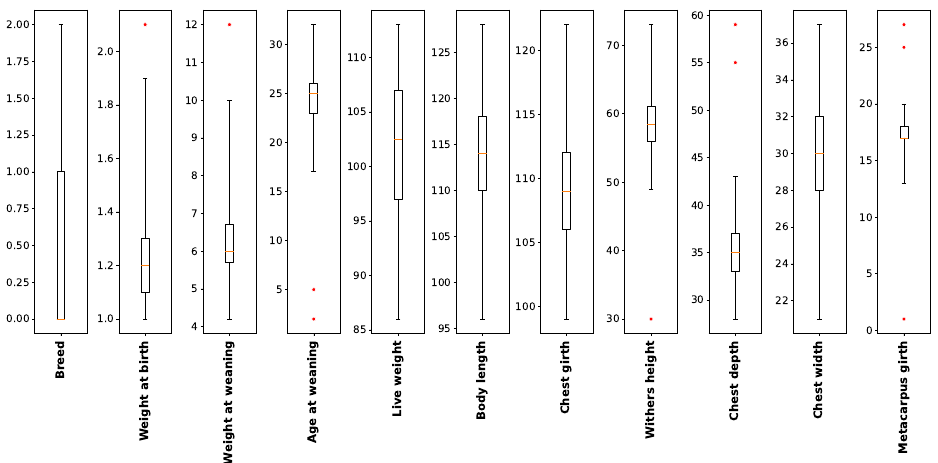
Figure 3. In the boxplots, the whiskers show the range, the boxes show the upper and lower quartile and median (solid dark horizontal line) values, and red points are outliers. Table 1. The mean values, standard deviation (SD), and coefficient of variation (CV) of each feature. Features